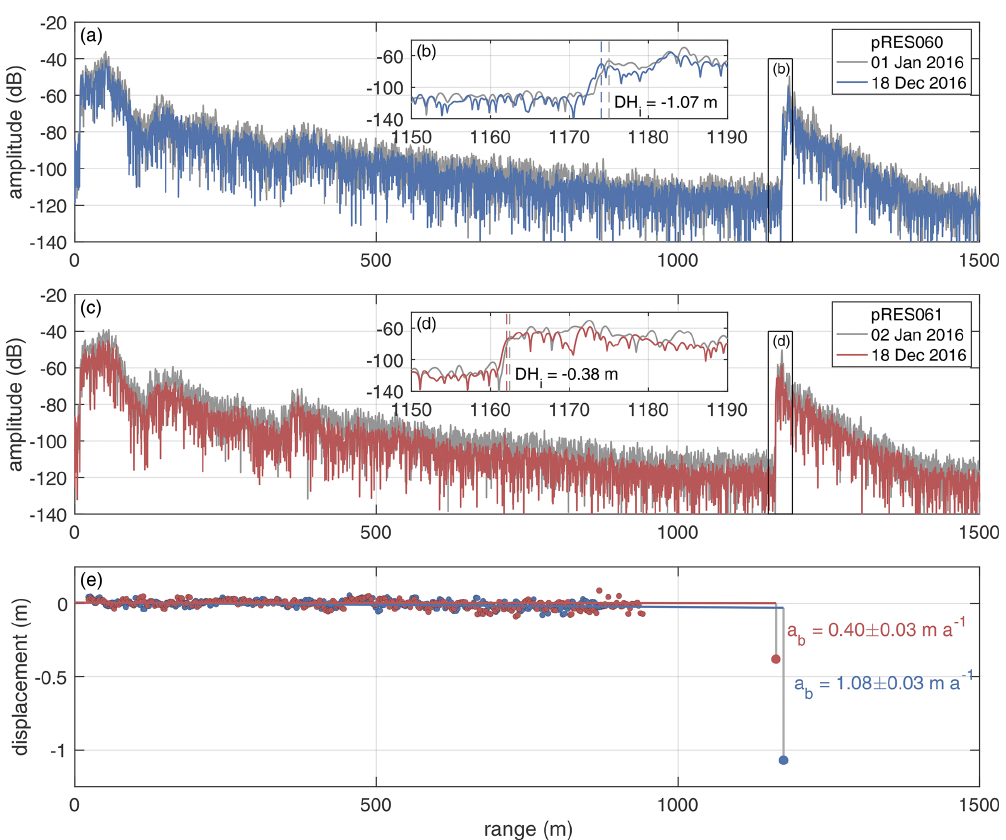
Figure B1. (a–d) Amplitude profiles of first (grey line) and repeated measurement at locations pRES060 ( a,b ; blue) and pRES061 ( c,d ; red). Insets in (b) and (d) showing enlarged basal section, visualised by black boxes in (a) and (c) . (b,d) Vertical dashed lines mark the ice thickness and D H i the change in ice thickness between both visits. The correlation coefficients of the basal segments are 0.95 (pRES060) and 0.96 (pRES061). (e) Vertical displacements of internal segment (small dots) and of the basal segment (large dot) for pRES060 (blue) and pRES061 (red). The values given are the basal melt rates at both